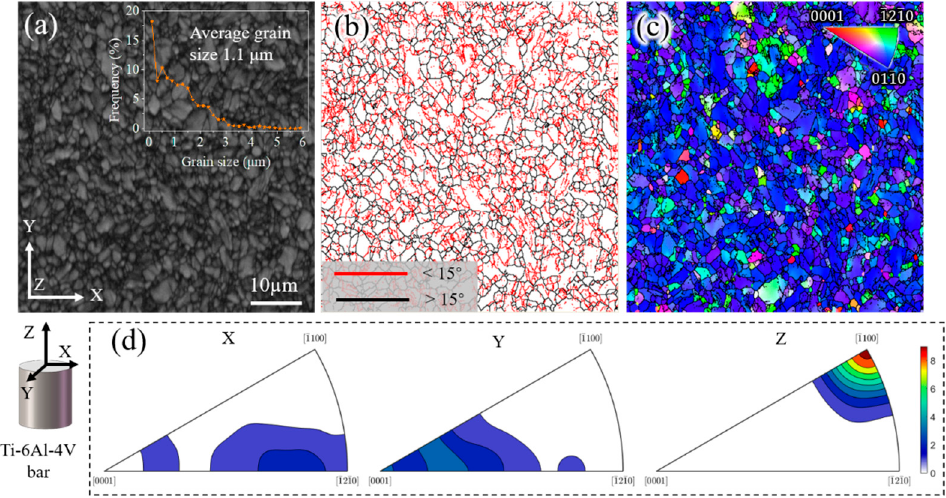
Figure 1. Microstructure of the as-received Ti-6Al-4V billet bar. ( a ) Band contrast and grain size; ( b ) grain boundaries map, where the grain boundaries colored red are <15° and black are >15°; ( c ) inverse pole figure map parallel to Z; and ( d ) inverse pole figures parallel to X, Y, and Z.